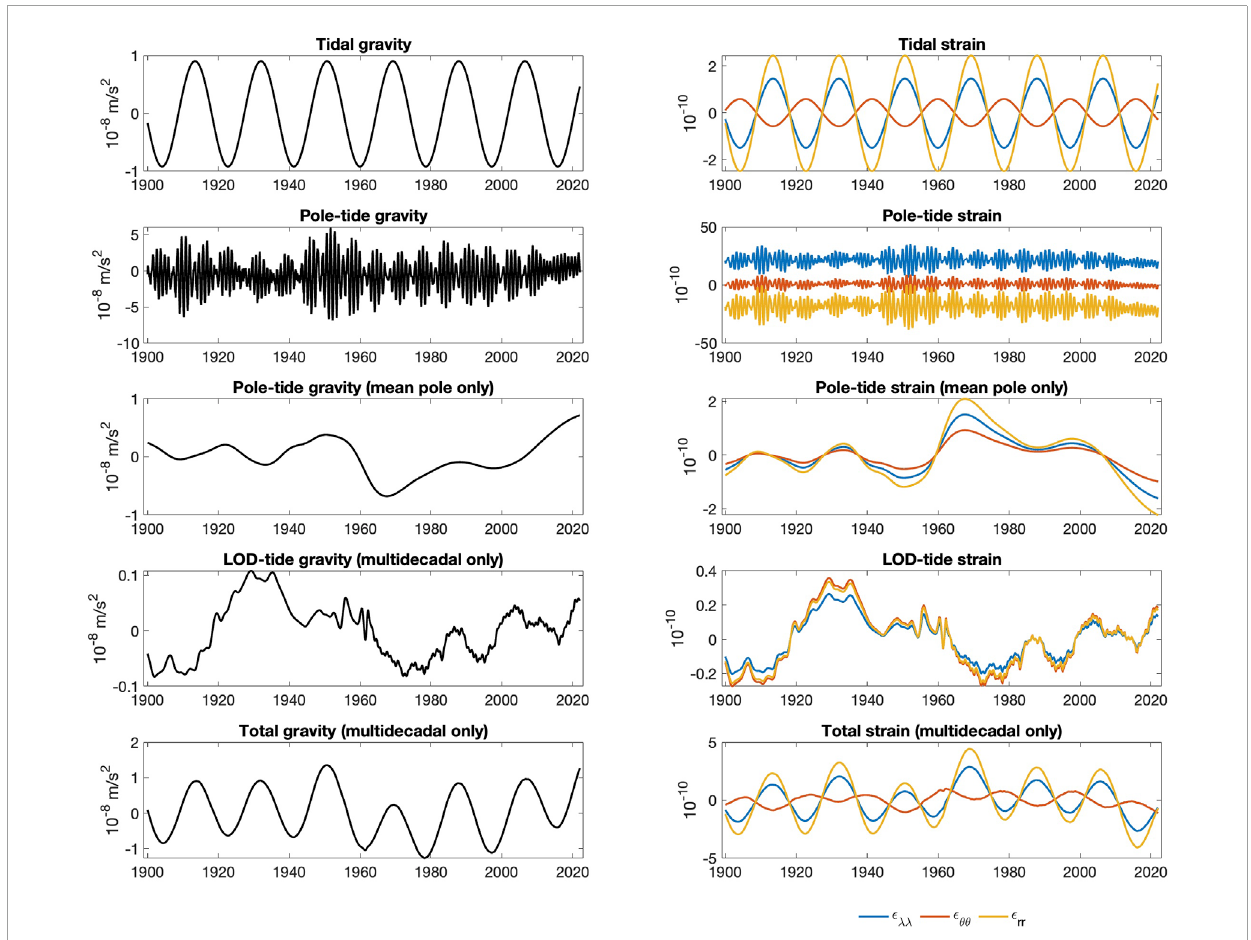
FIGURE 4 Various contributions in the variations of the tidal strain and gravity since 1900 computed for a north latitude of 41 ° and east longitude of 14 ° . In the right panels, ϵ λλ is the horizontal, eastward component of the surface strain tensor, ϵ θθ is the horizontal, southward component, and ϵ rr is the radial (vertical) component. For readability purpose, ϵ λλ and ϵ rr in the second row, right column have been shifted by 20 × 10 −10 and − 20 × 10 −10 , respectively. As well, ϵ λλ and ϵ rr in the fourth row, right column have been shifted by 0 . 4 × 10 −10 and − 0 . 4 × 10 −10 ,